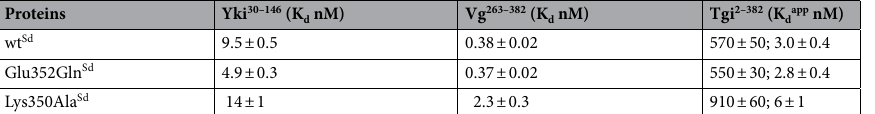
Table 2. Affinity of Yki/Vg/Tgi for wt Sd , Glu352Gln Sd and Lys350Ala Sd . The affinity (K d ) was measured by Surface Plasmon Resonance in experiments where the biotinylated-Avitagged-Sd proteins were immobilized on sensor chips. Two apparent K d values, K dapp , were obtained for Tgi because this protein contains two binding sites for Sd (for details see 28 ). Averages and standard errors are given (n ≥